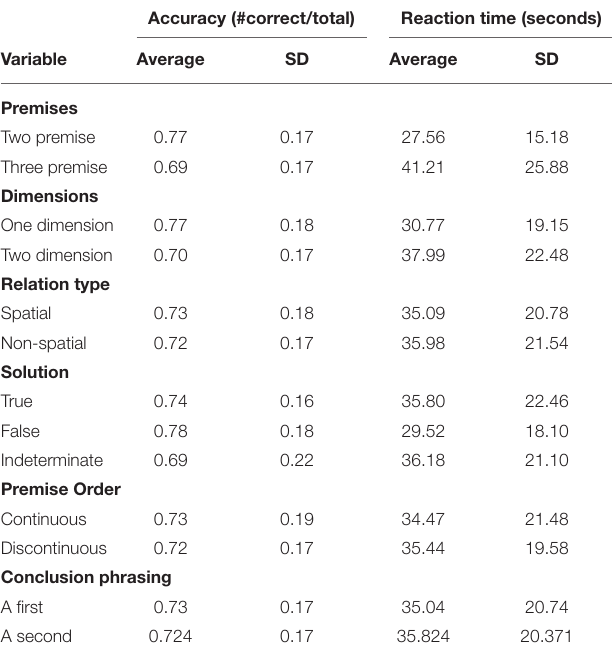
TABLE 1 | Descriptive results for each stimulus